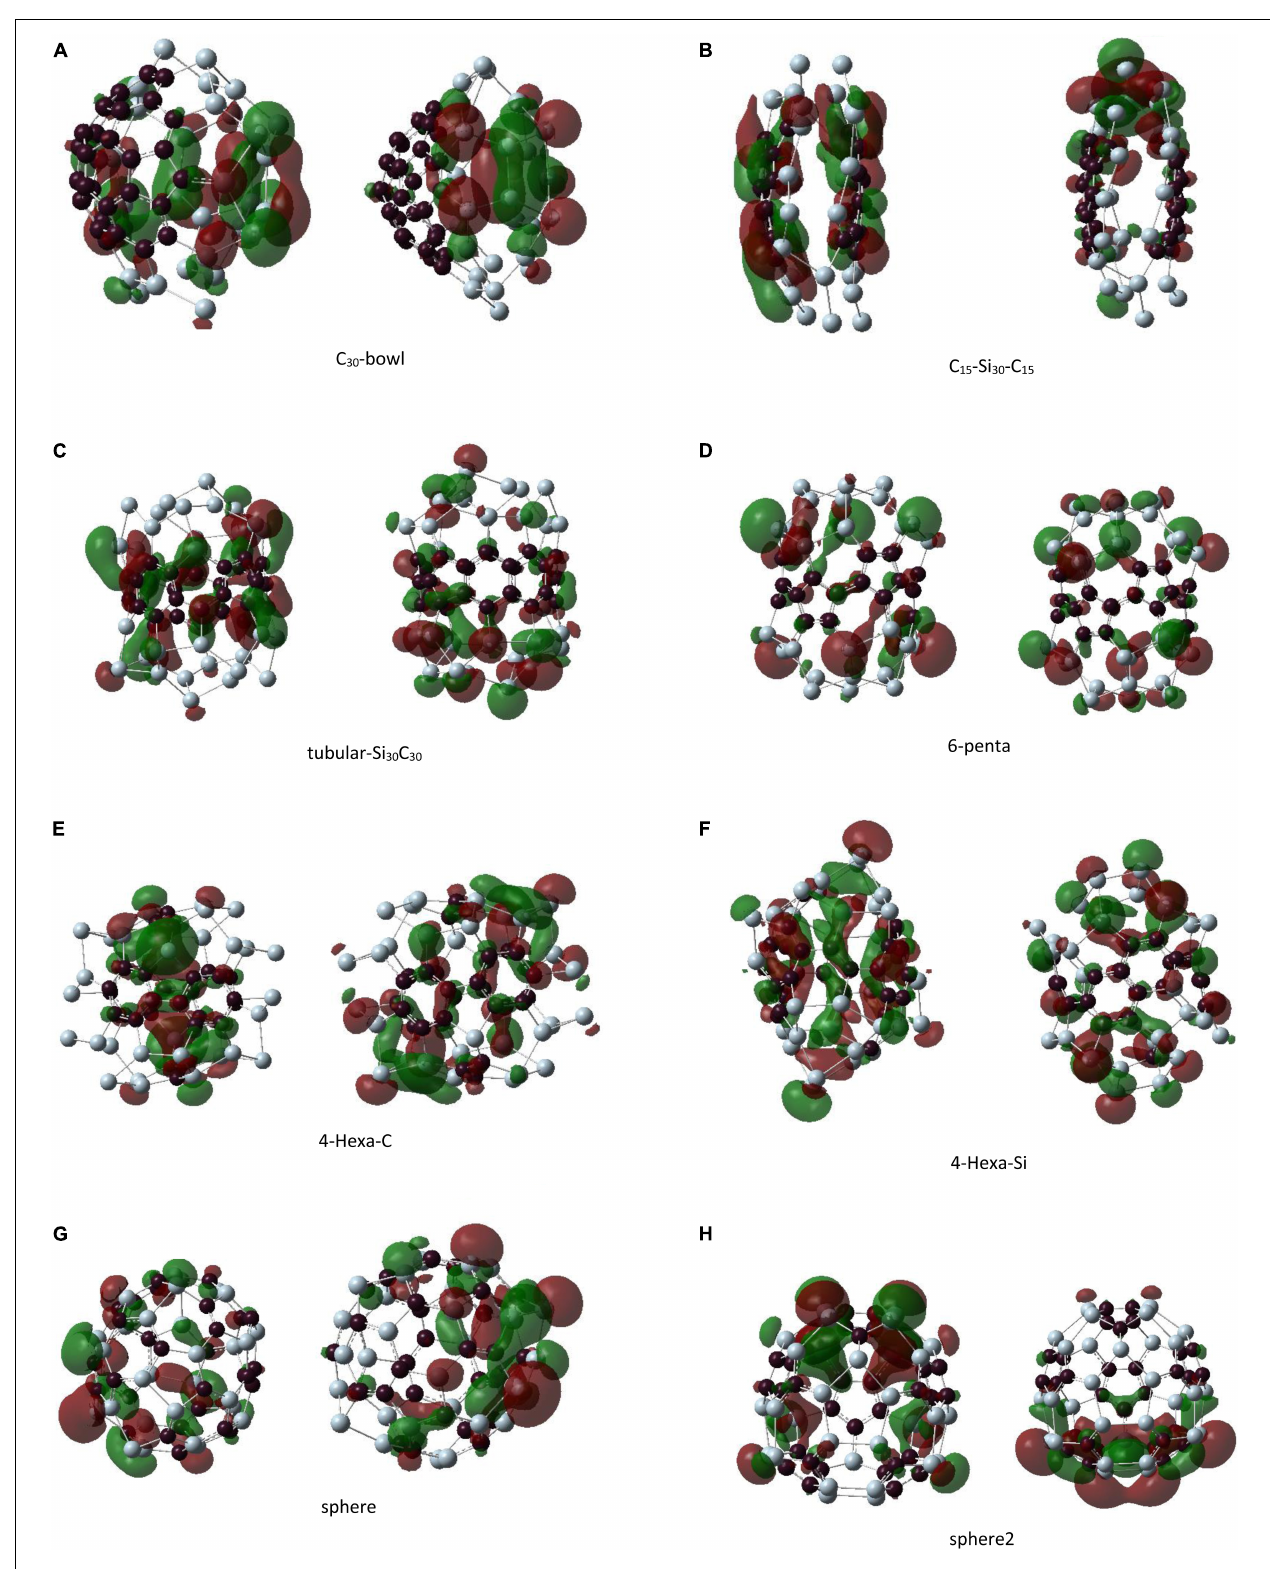
FIGURE 7 | The left panel shows the highest occupied molecular orbital and the right panel shows the lowest unoccupied molecular orbital plots for unpassivated Si 30 C 30 clusters. Structures are presented from panels (A–H) in order of their stability, most to least stable.